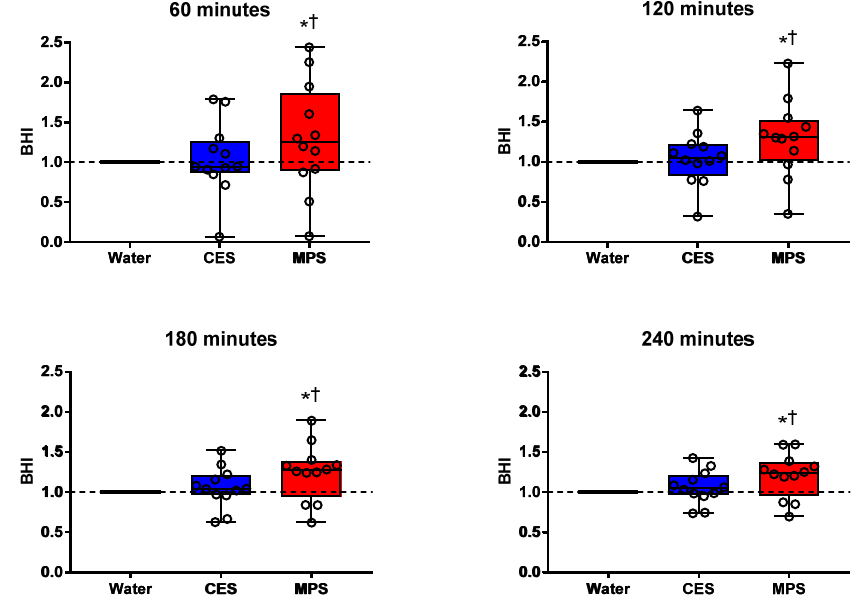
Figure 3. Beverage Hydration Index (BHI) for a carbohydrate–electrolyte solution (CES) and a milk permeate-based solution (MPS) relative to water (BHI = 1). The BHI for MPS was significantly higher compared to both water and CES at all time points after ingestion. BHI did not di ff er between water and CES at any time point. Boxes represent first and third quartiles with median values denoted by the horizontal line, while whiskers indicate minimum and maximum observations. Individual subjects’ BHIs are displayed as open circles. Di ff erences between beverages were assessed by two-way ANOVA. * p < 0.05 MPS compared to water; † p < 0.05 MPS compared to